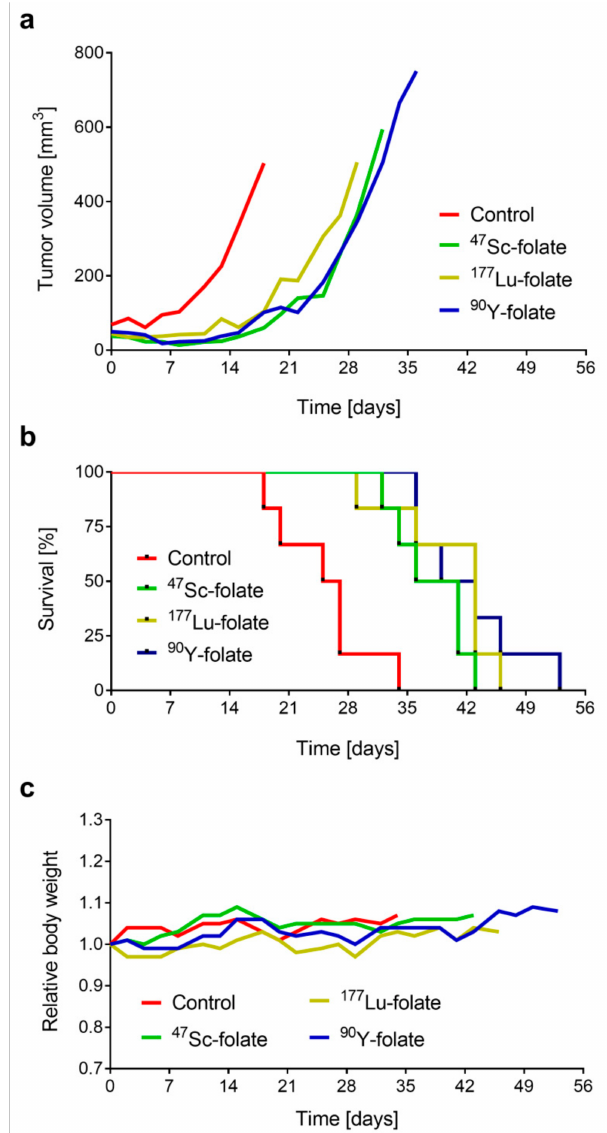
Figure 3. Results of the therapy study of mice which received ~21 Gy tumor dose. ( a ) Tumor growth curves indicated as the average of IGROV-1 tumor sizes in mice treated with 47 Sc-, 177 Lu-, and 90 Y-folate, respectively. ( b ) Survival curves of mice treated with 47 Sc-, 177 Lu-, and 90 Y-folate resulting in median survival times of 39, 43, and 41 days, respectively. ( c ) Relative body weight of mice from each group over the period of